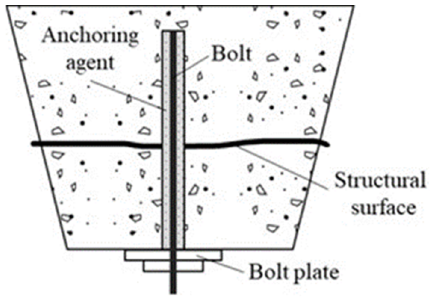
Figure 1. Schematic diagram of anchored structural surface.